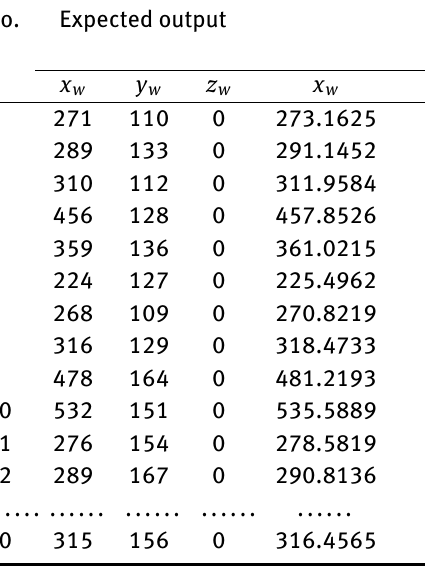
the increase amplitude was very small; when the noise reached 0.07 times, the calculation time was 0.271 s, which was only 0.026s longer than that in the case of no noise, indicating that the feature extraction algorithm designed in this study could meet the real-time requirement.